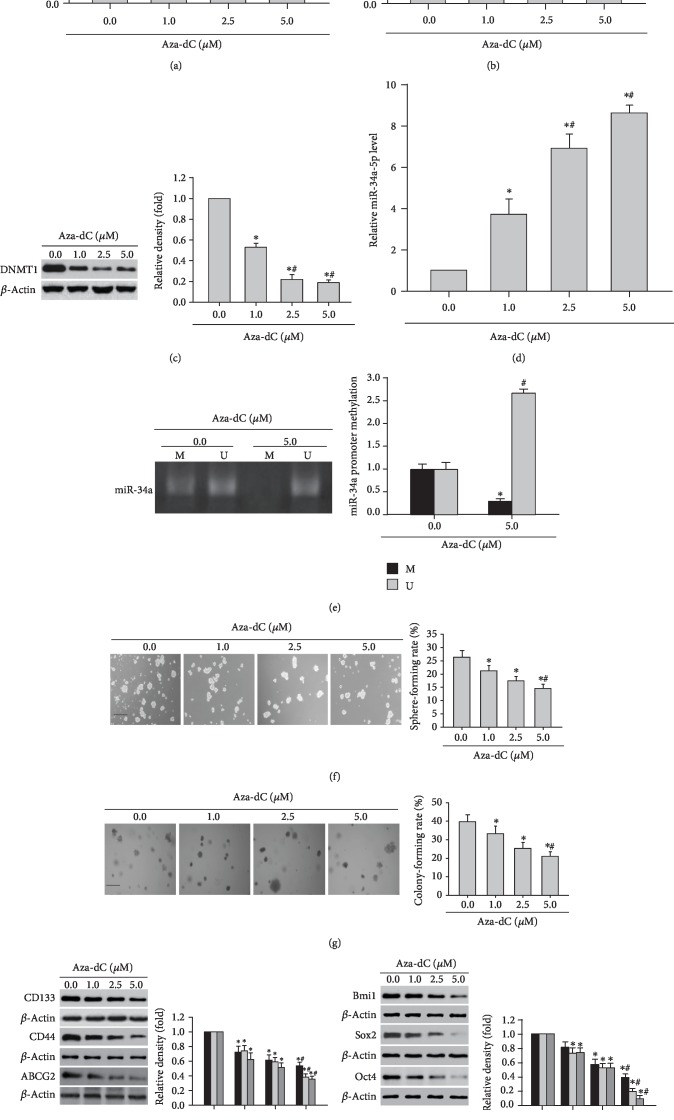
Effects of Aza-dC on the stemness feature in OSLCs. (a) The activity of DNMT1 in OSLCs treated with Aza-dC was assessed by ELISA. (b) The level of DNMT1 mRNA of OSLCs treated with Aza-dC was determined by qRT-PCR. (c) Immunoblotting was used to analyze the expression of DNMT1 of OSLCs treated with Aza-dC (left), as well as its densitometric analysis (right), with β-actin serving as a loading control. (d) The miR-34a-5p level of OSLCs treated with Aza-dC was detected by qRT-PCR. (e) The effect of Aza-dC on OSLC miR-34a-5p promoter methylation (M, methylated miR-34a-5p promoter; U, unmethylated miR-34a-5p promoter). (f) Representative images of the sphere formation of OSLCs treated with Aza-dC (left) (scale bar, 200 μm), and the sphere formation assay was used to assess the sphere-forming rate (right). (g) Representative images of the colony formation of OSLCs treated with Aza-dC (left) (scale bar, 200 μm), and the colony-forming rate of OSLCs was determined by the colony formation assay (right). (h) CD133, CD44, and ABCG2 proteins of OSLCs treated with Aza-dC (left) and their densitometric analysis (right). (i) Bmi1, Sox2, and Oct4 of OSLCs treated with Aza-dC. ∗p < 0.05 (n = 3) vs. the DMSO control; #p < 0.05 (n = 3) vs. OSLCs treated with Aza-dC (1.0 μM).